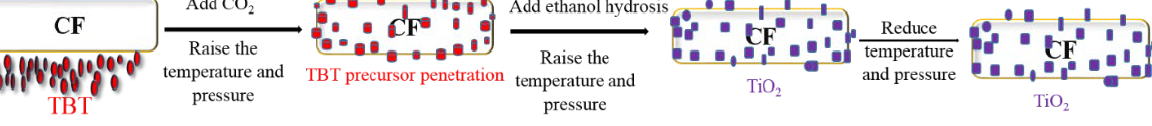
Figure 2. The process of synthesizing TiO 2 for CF in SCCO 2 .